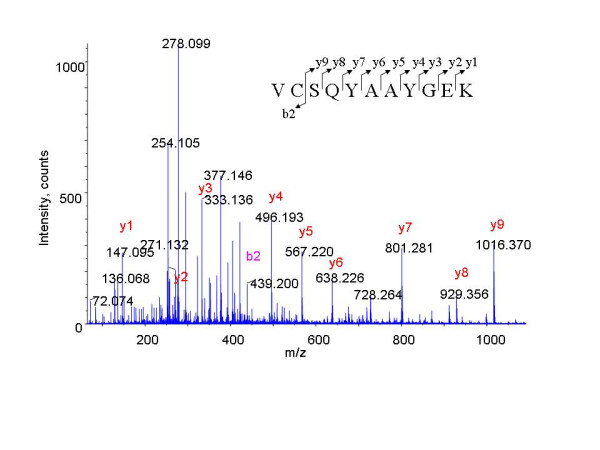
Identification of the peptide VC*SQYAAYGEK from vitamin D-binding protein by MS/MS.